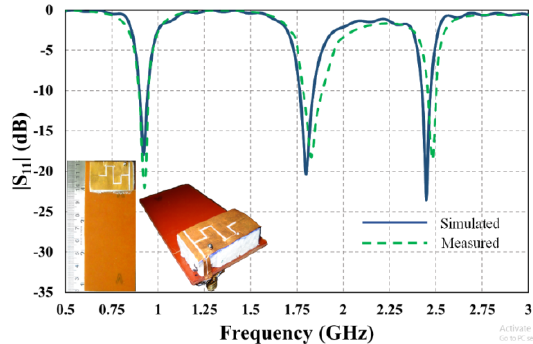
Figure 7: Measured and simulated |S 11 | dB of the antenna. ( L s =56mm, g =1.25mm, parasitic patch size= 20mm × 2.4mm